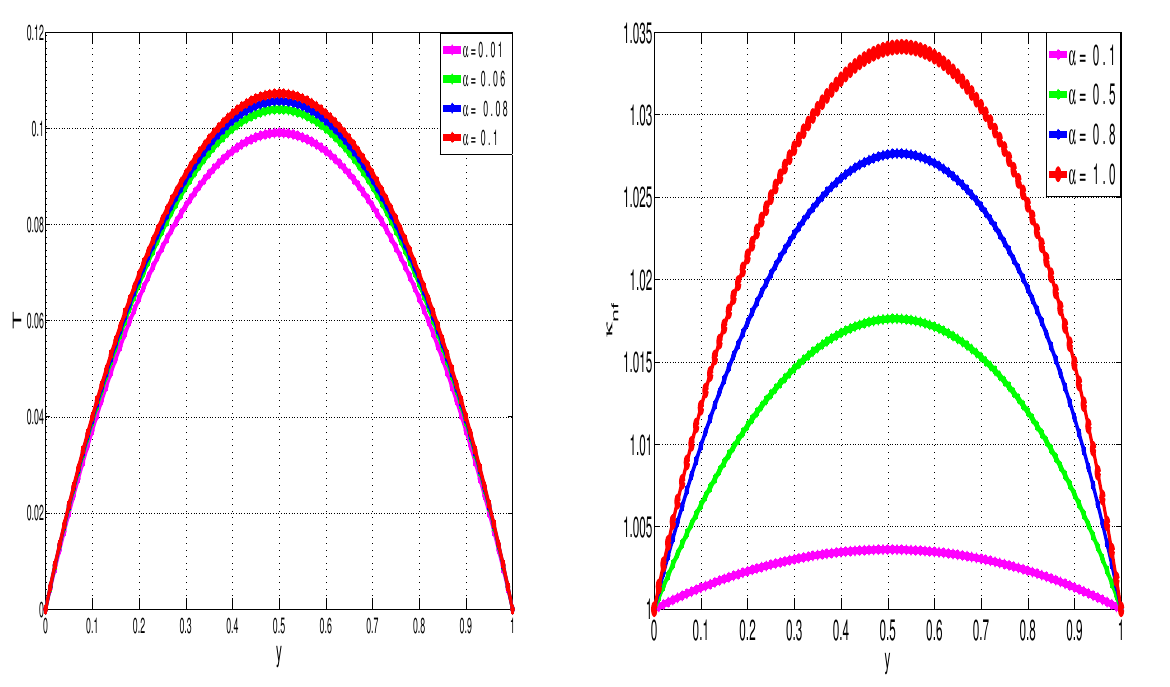
Figure 18. Sensitivity of VFBN temperature ( left ) and thermal-conductivity ( right ) to variations in α